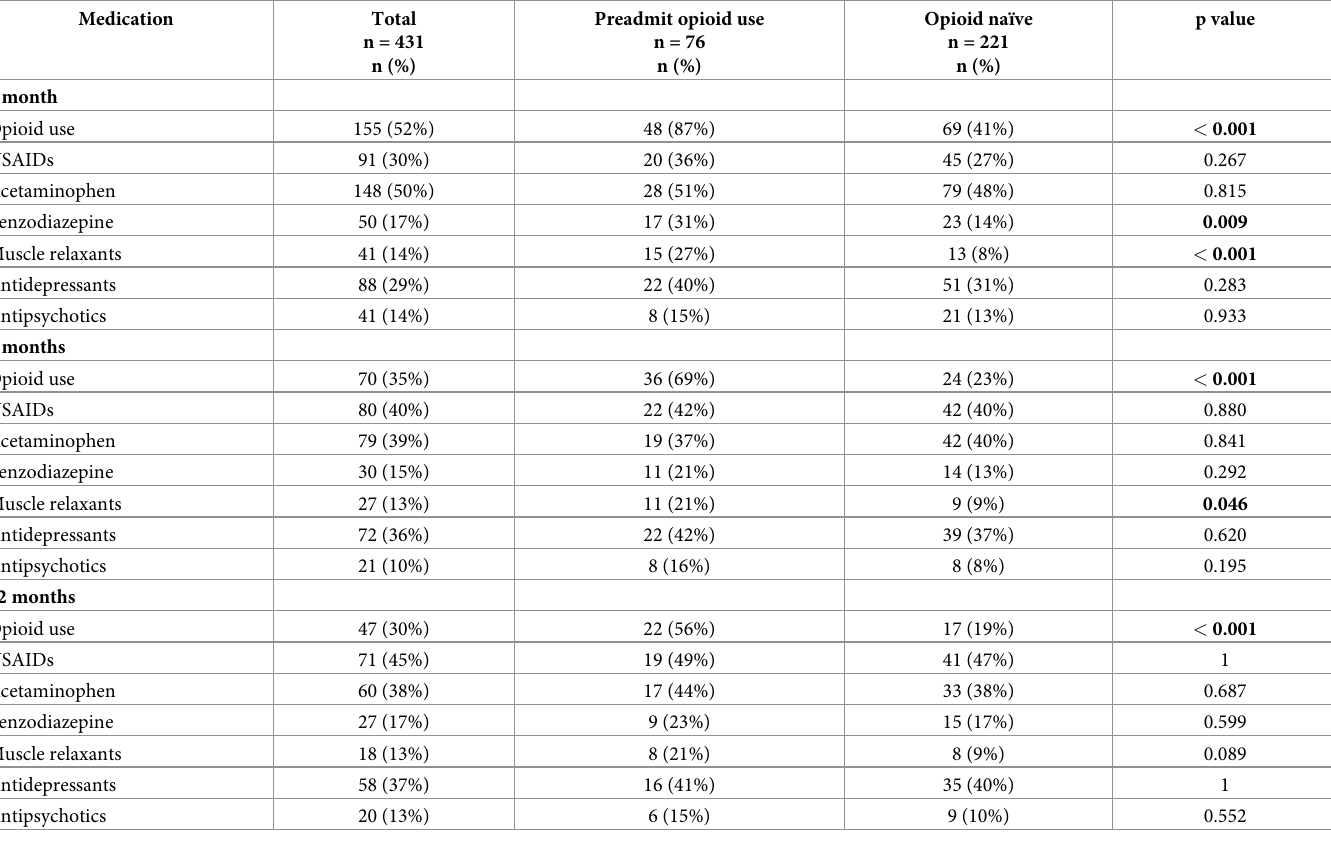
Data presented as number